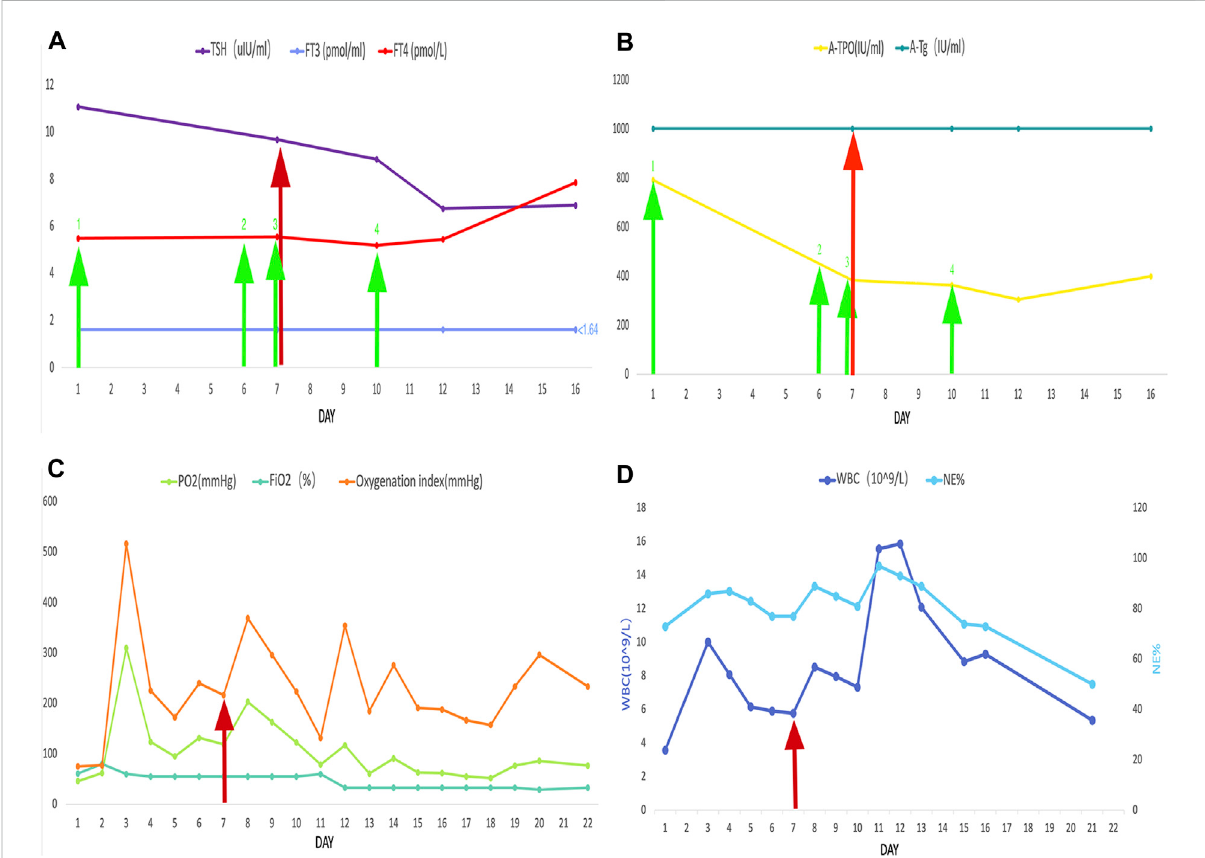
FIGURE 2 The red arrow represents the start of the use of glucocorticoids. The green arrow represents the levothyroxine administration. The numbered green arrows indicate the administered doses as follows: 1, 25 mg/d; 2, 50 mg/d; 3, 100 mg/d; 4, 125 mg/d. The following are also shown: (A) thyroid-stimulating hormone, free triiodothyronine, and, free thyroxine; (B) thyroid peroxidase antibody and thyroglobulin antibodies; (C) PO 2 , FiO 2 , and oxygenation index; (D) white blood cell count and